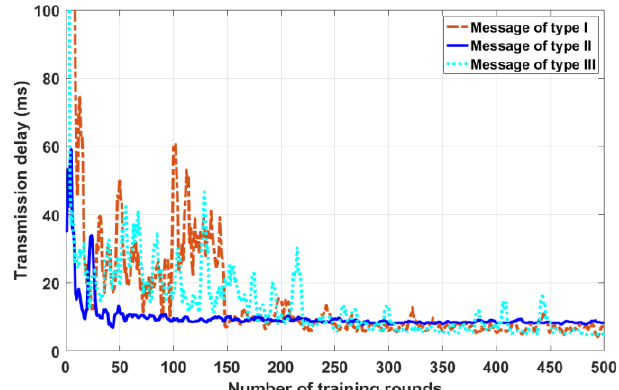
Figure 2. The proposed strategy is aimed at the convergence of random snapshots.